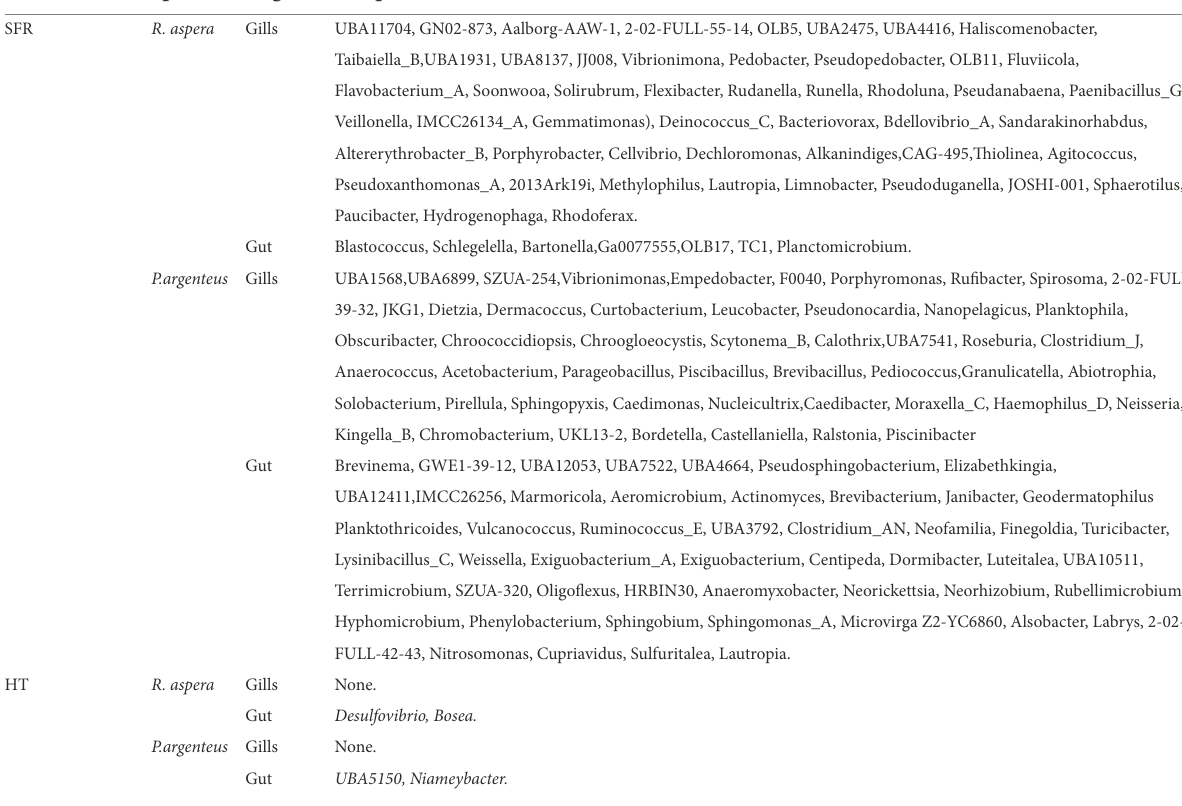
TABLE 2 Unique communities at the genera level of the gill and gut microbiomes of species recruited from the SFR and